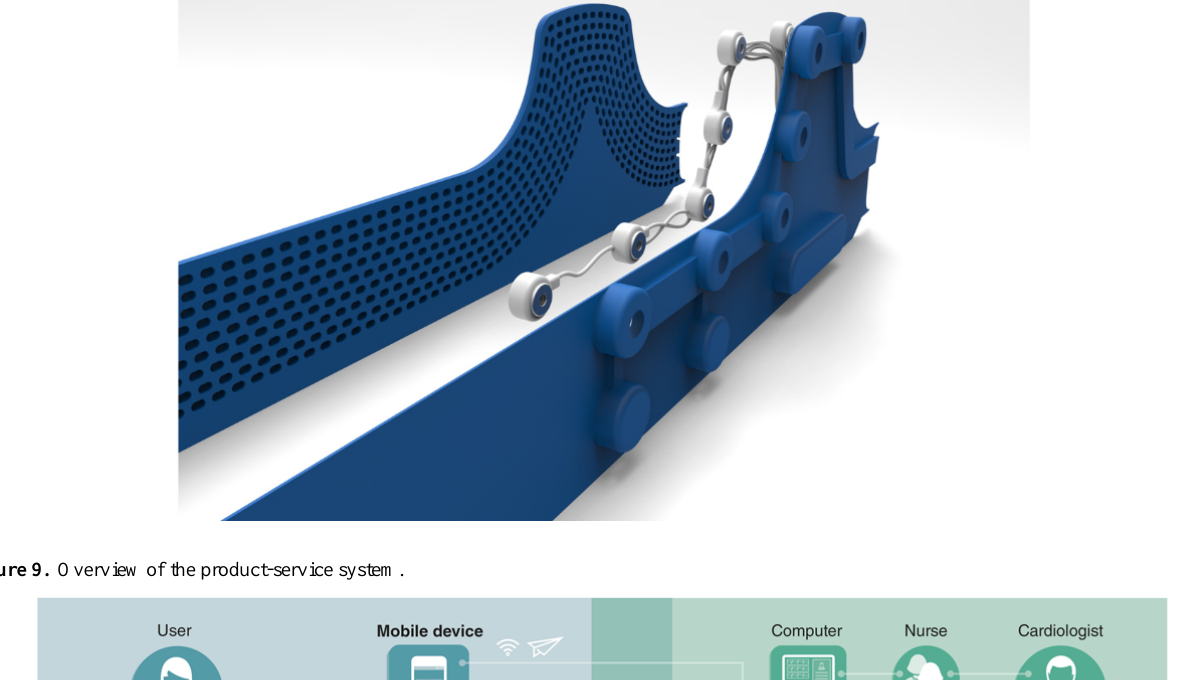
Figure 8. The electrode system is sandwiched between two layers of cast rubber, one of which is perforated to create a larger strain.